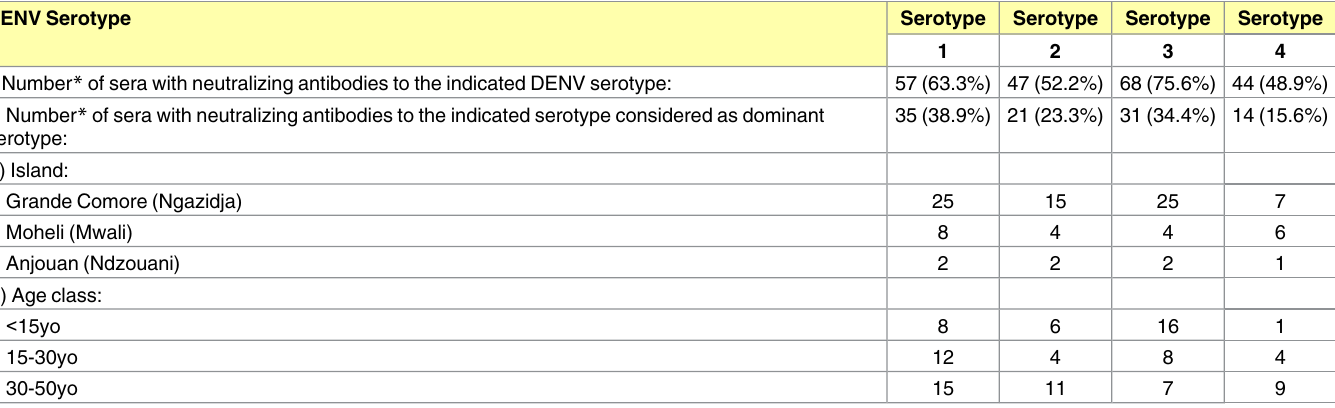
Table 4. Number of sera with neutralizing antibodies to DENV serotypes1–4 according to (i) the neutralized serotype(s), (ii) the dominant sero- type, (iii) the Island and (iv) the age class. Presented data concerna subset of 90 randomlyselectedDENV ELISA positive samples. ( * Numbers may not add up as one individualserum may react with more than one serotype).